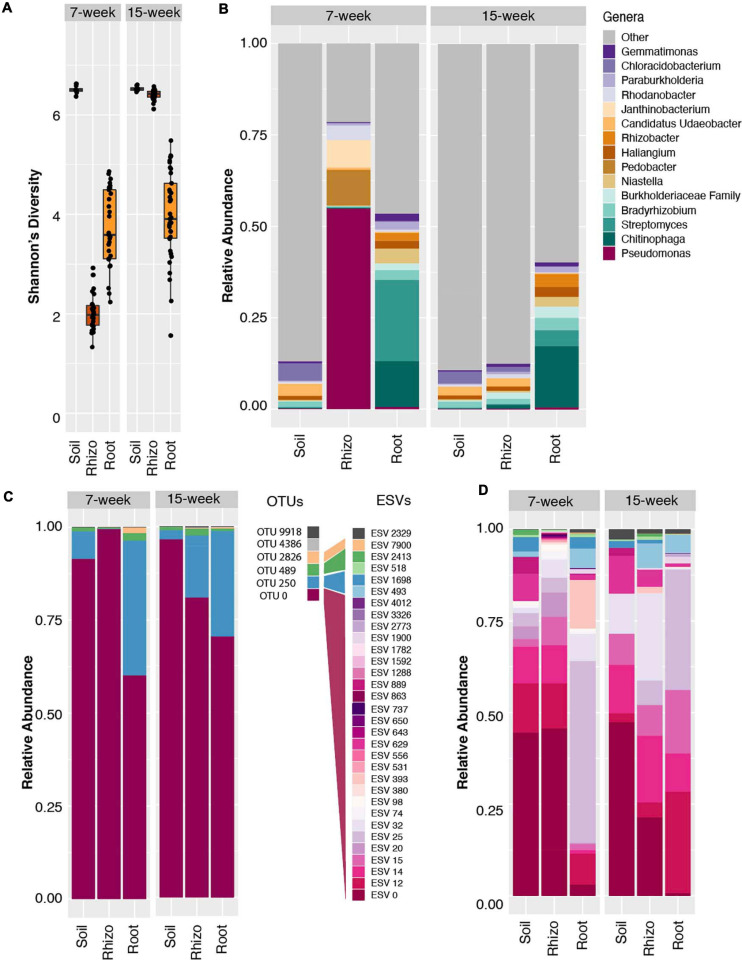
Amplicon data reveals Pseudomonas dominance and reduced alpha diversity in 7 week sorghum rhizosphere. (A) Boxplots of Shannon’s diversity for soil, rhizosphere and root samples at the 7 week (left panel) and 15 week (right panel) time points using the 97% clustered OTU dataset. (B) Relative abundance barplots for the top fifteen most abundant genera in the 97% clustered OTU dataset indicate the Pseudomonas genus accounts for ∼60% of the reads within the rhizosphere 7 week samples, but significantly less in other timepoints and sample types, with parallel increases in Pedobacter and Janthinobacter genera. (C) Relative abundance of all six identified Pseudomonas OTUs with 97% clustering indicates that the majority of read counts in all sample types map to OTU 0. (D) Relative abundance barplots for all Pseudomonas ESVs derived from the same 16S amplicon data analyzed using DADA2. Of the resulting 32 Pseudomonas ESVs identified in this analysis, 26 (shown in shades of pink and purple) mapped to the dominant OTU 0, as determined by a sequence similarity threshold of 97% in pairwise alignment to all six Pseudomonas OTUs. ESVs mapping to three of the other Pseudomonas OTUs are indicated with shades of blue, green, and yellow. Note that OTU and ESV numberings are independent of each other.